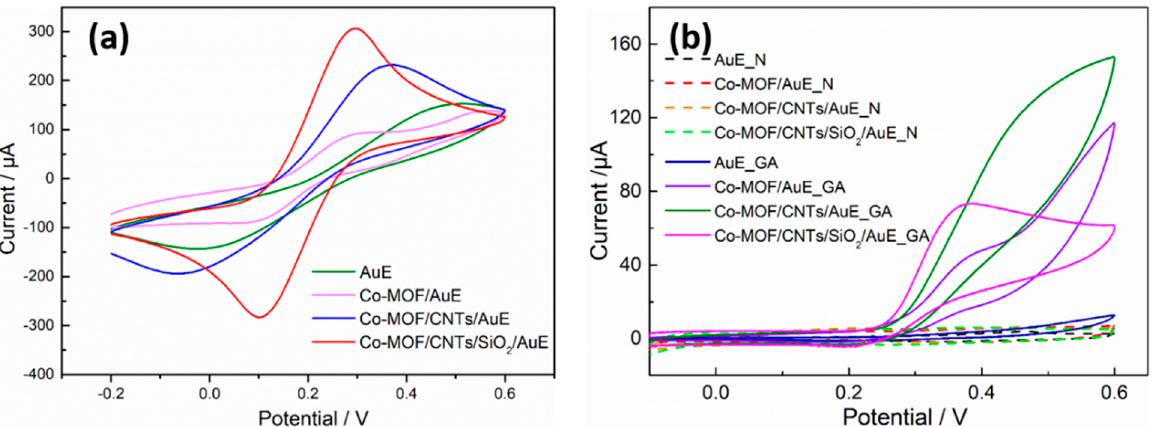
Figure 4. CV curves of the bare AuE, Co-MOF/AuE, Co-MOF/CNTs/AuE and Co-MOF/CNTs/SiO 2 /AuE in 0.1 M KCl solution containing 5 mM K 3 [Fe(CN) 6 ]/K 4 [Fe(CN) 6 ] ( a ); CV curves of bare AuE, Co-MOF/AuE, Co-MOF/CNTs/AuE and Co-MOF/CNTs/SiO 2 /AuE for 1 mM GA or without GA (pH = 5) ( b ).